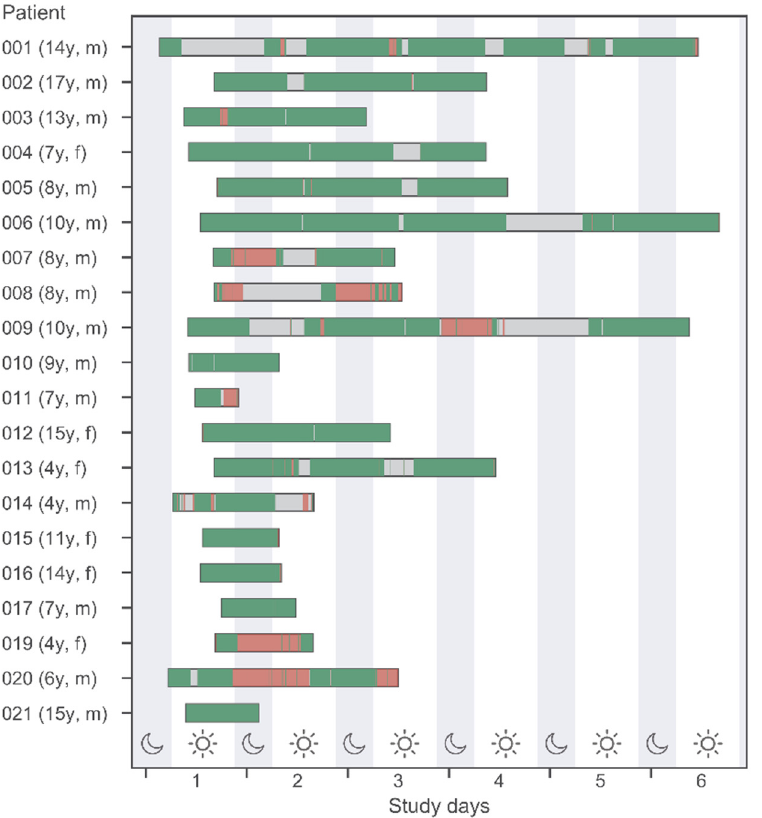
Figure 1. Data availability of measured vital signs by the Everion ® WD and conventional measure- ments at night- and daytime (22 h-06 h-22 h). Green and red bands indicate good and bad quality data according to quality filters described in Section 2.3.5 “statistical analysis”. Gray bands indicate no data available.